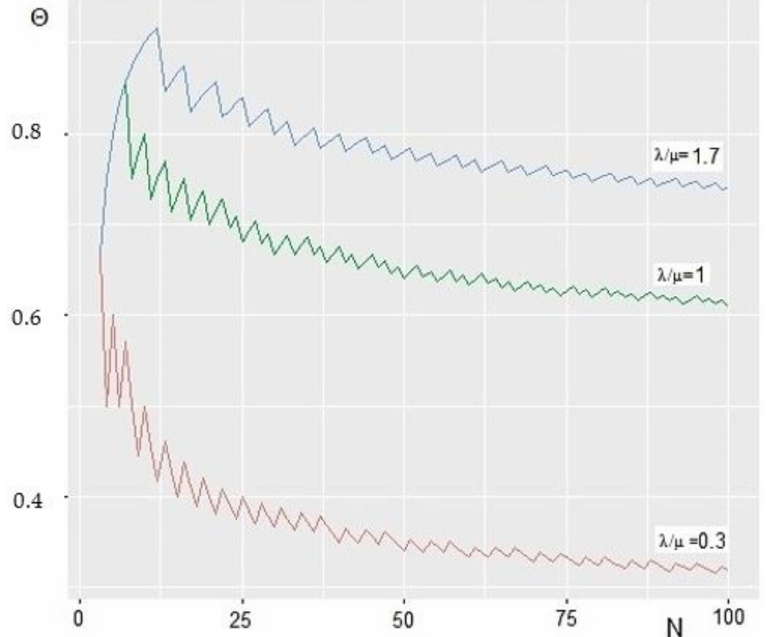
Figure 8. Simulation of the optimal number of m vehicles for the value λ / µ = 0.3, λ / µ = 1, and λ / µ = 1.7 ( ρ = λ ). µ